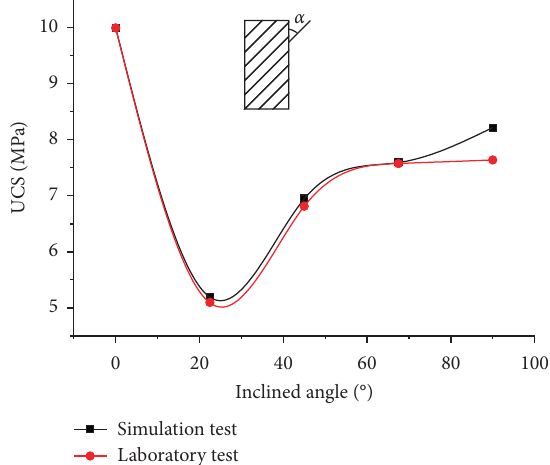
Figure 12: The UCS value of simulation test and laboratory test plotted as a function of the inclined